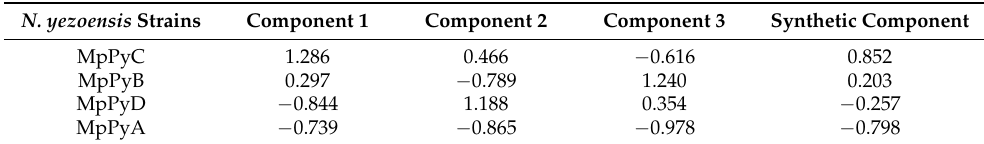
Table 4. Principal component value of nutritional components of N. yezoensis strains. The abbrevia- tions were the same in Table 1.